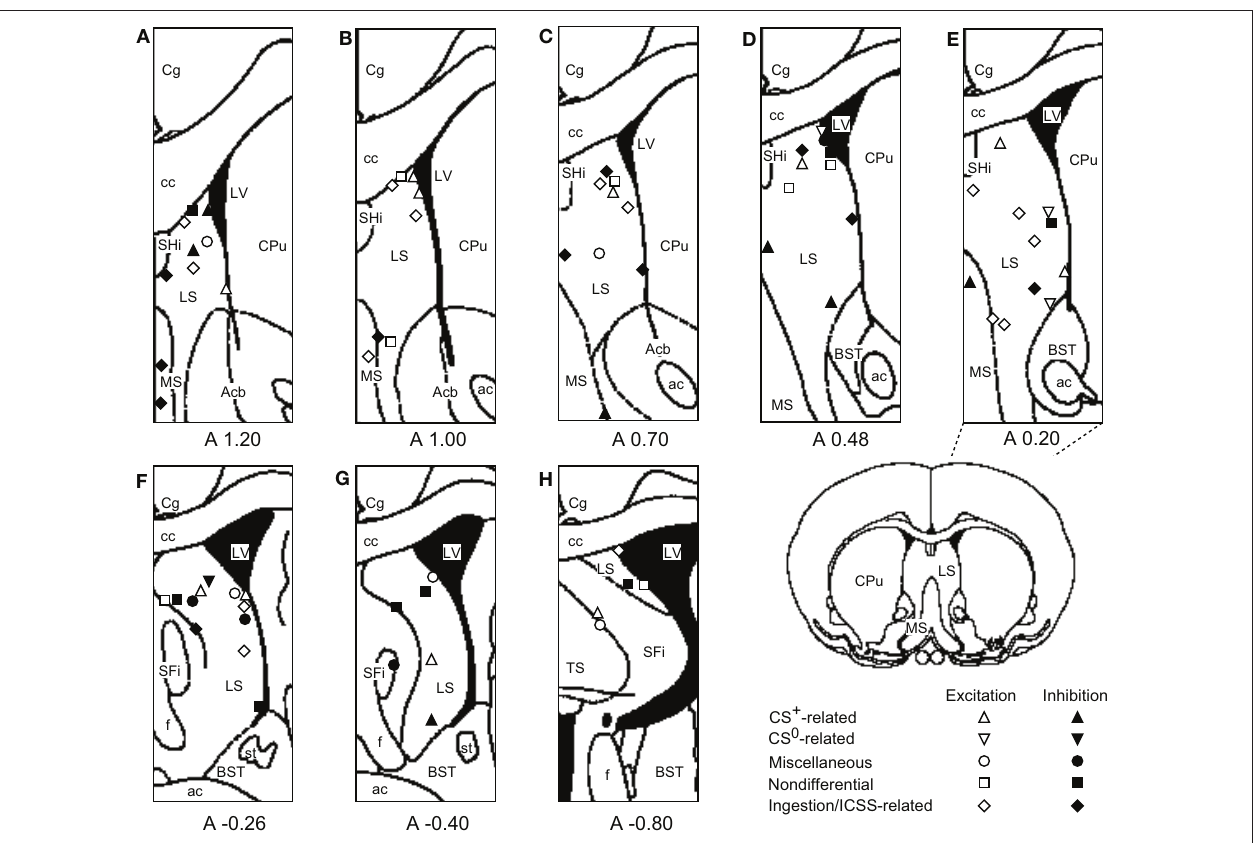
conditioned stimulus predicting non-reward (CS 0 )-related neurons; circles, miscellaneous differential neurons; squares, non-differential neurons; diamonds, ingestion/intracranial self-stimulation (ICSS)-related neurons. Other descriptions as in Figure